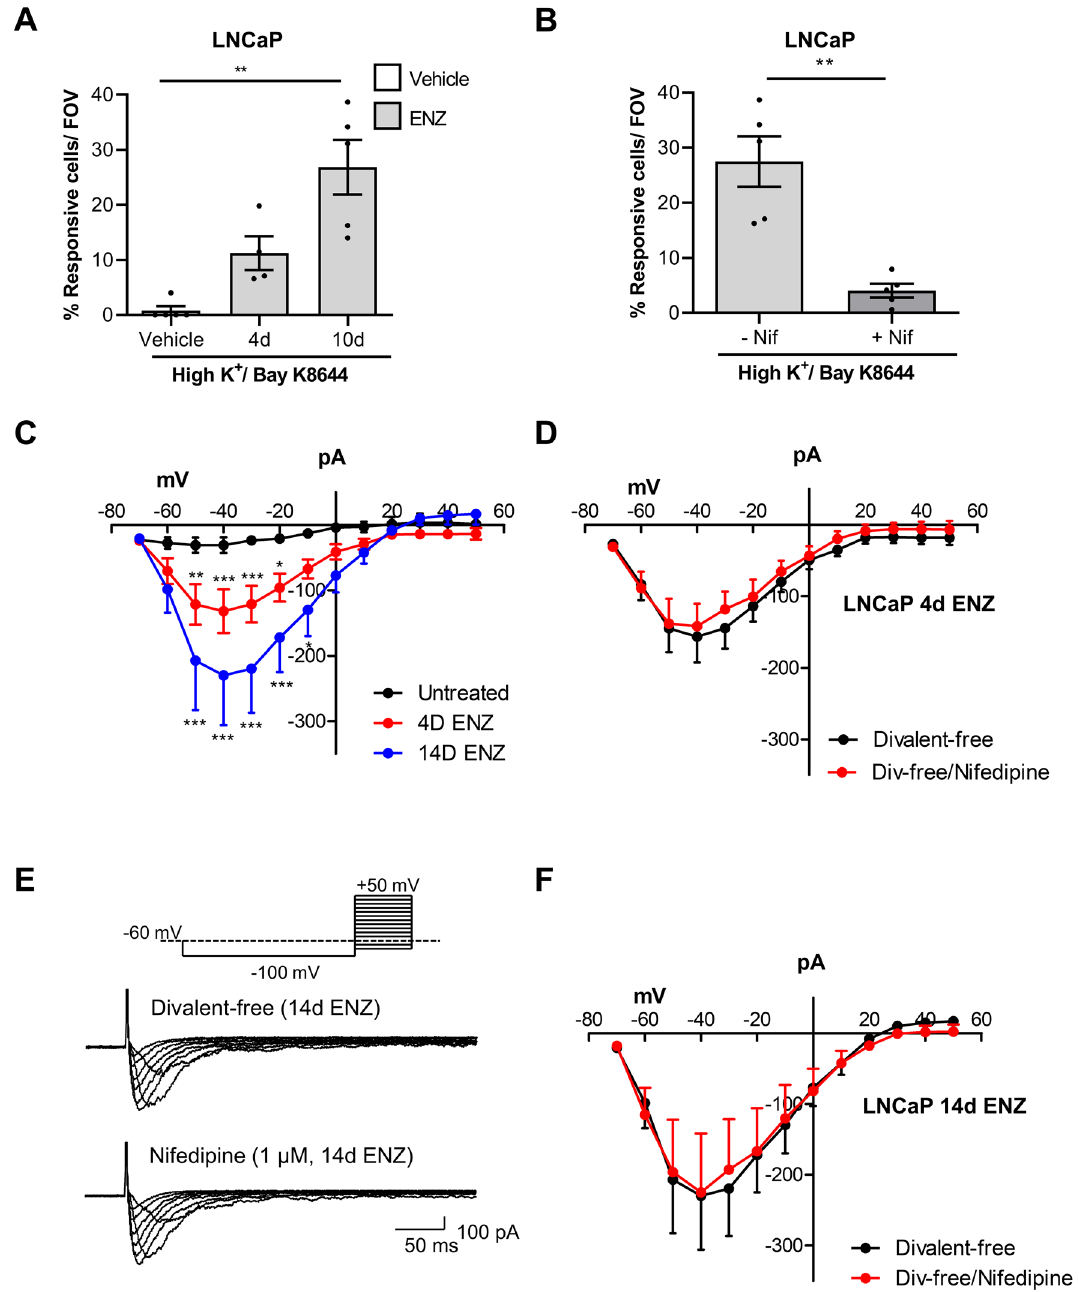
Figure 6. Ca V -mediated Ca 2+ signalling in LNCaP after Enzalutamide treatment. ( A ) LNCaP exhibited high K + / Bay K8644-Ca 2+ -transients after ENZ for 4 days or 10 days; Kruskal–Wallis with Dunn’s multiple comparison test, p < 0.01 (**) (N = 3). ( B ) The percentage of cells, treated with ENZ for 10 days, responding to the stimulus was significantly reduced in the presence of nifedipine (1 µM, unpaired t-test, p < 0.01 (**) (N = 3). Note, data for 10 day ENZ in the absence of nifedipine is replotted from panel ( A ). ( C ) Summary current–voltage plot of divalent-free currents in untreated, ENZ-LNCaP 4 days and 14 days treatment (n = 8, N = 2 cultures; n = 11, N = 4 cultures; n = 5, N = 2 cultures respectively). Two-way ANOVA, Bonferroni post-hoc tests showed significant increase in mean current between untreated vs 4 days ENZ, or untreated vs 14 days ENZ (*p < 0.05, **p < 0.01; ***p < 0.001). ( D ) Summary current–voltage plot for ENZ-LNCaP (4 days treatment) (n = 9 cells, N = 4 cultures) currents recorded in divalent-free before and after nifedipine (1 μM). ( E ) Representative recordings from ENZ- LNCap (14 days) in divalent-free and in nifedipine. ( F ) Summary current–voltage graph showing currents in absence and presence of nifedipine, ENZ-LNCaP after 14 days treatment (n = 5 cells, N = 2